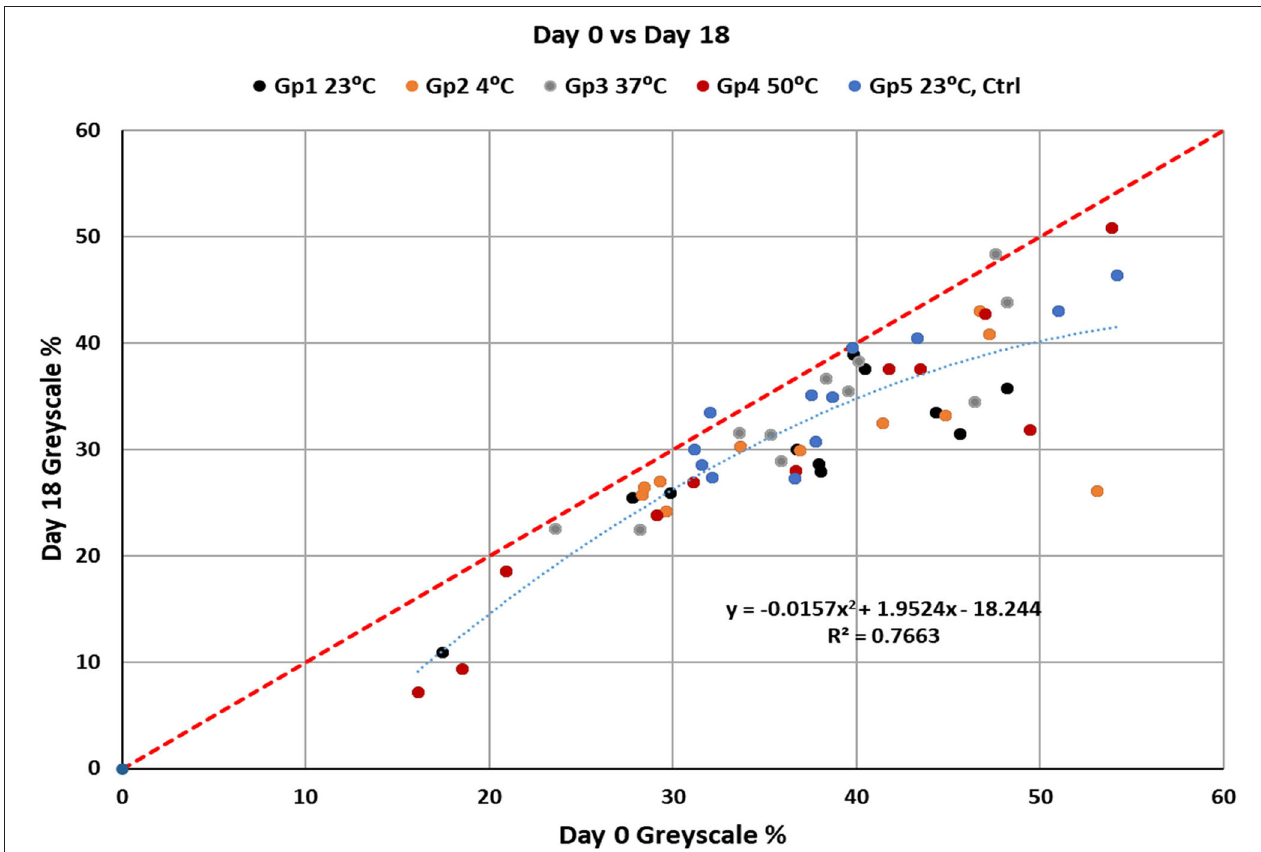
FIGURE 6 | The relationship between change in grayscale % from the value at day 0 to day 18. The polynomial fit of the data shows that lighter dentin samples will take up more change in grayscale % than darker dentin samples over time.